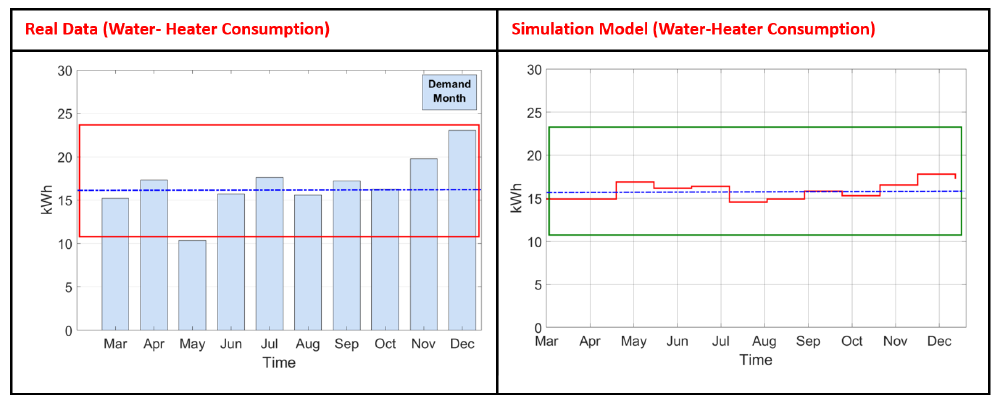
Figure 11. Real data vs. Simulation model (Oven).